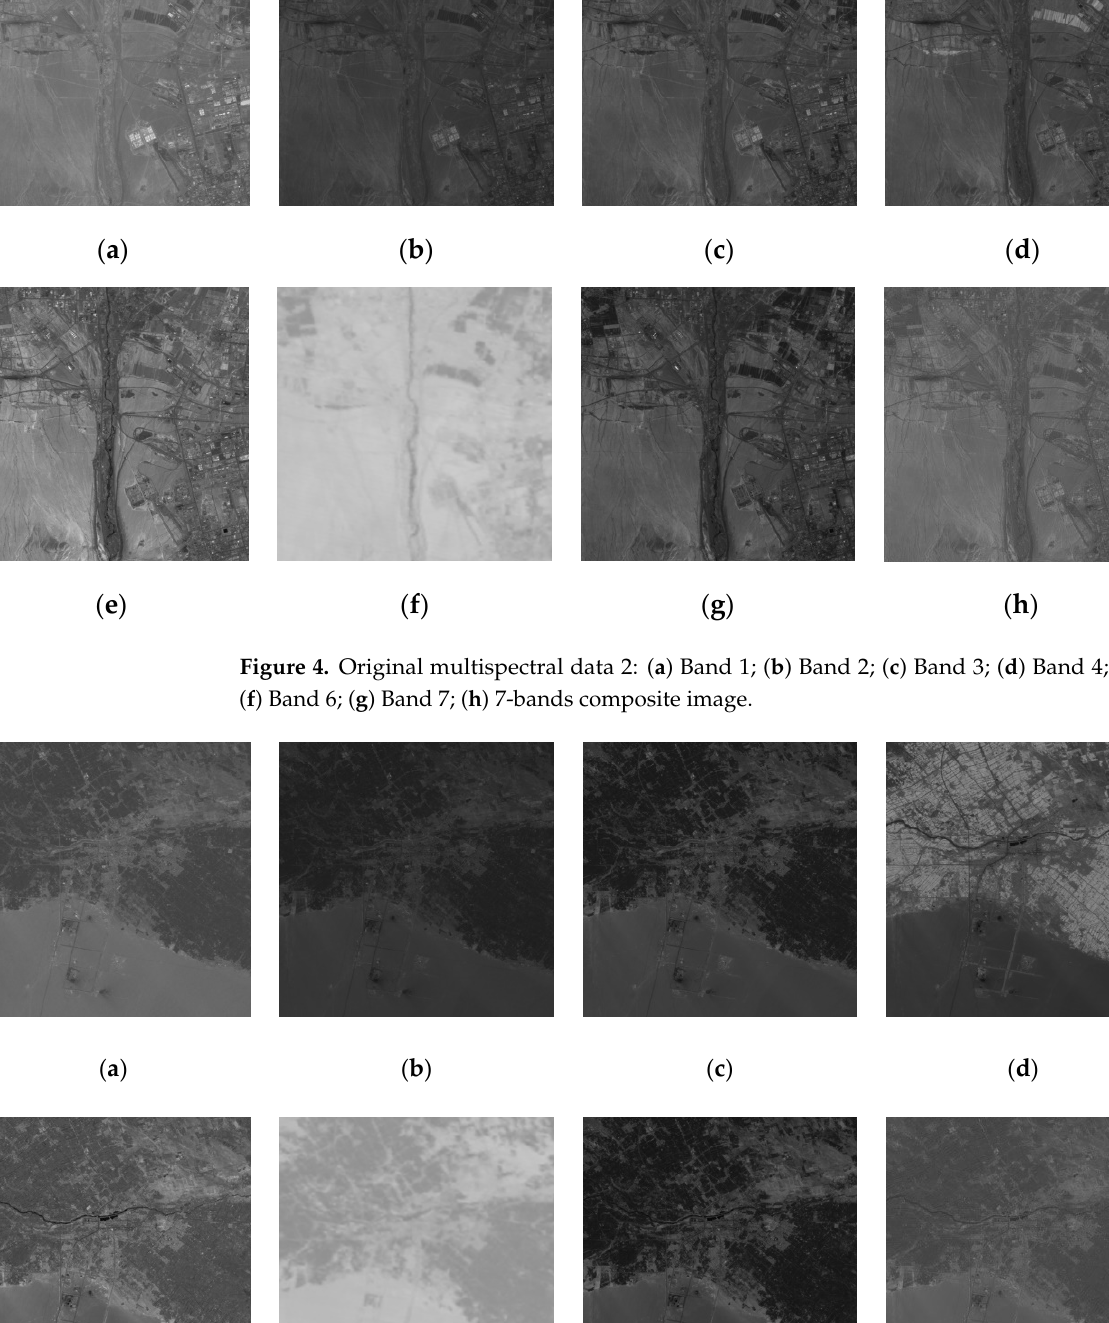
Figure 3. Original multispectral data 1 : ( a ) Band 1; ( b ) Band 2; ( c ) Band 3; ( d ) Band 4; ( e ) Band 5; ( f ) Band 6; ( g ) Band 7; ( h ) 7-bands composite image.